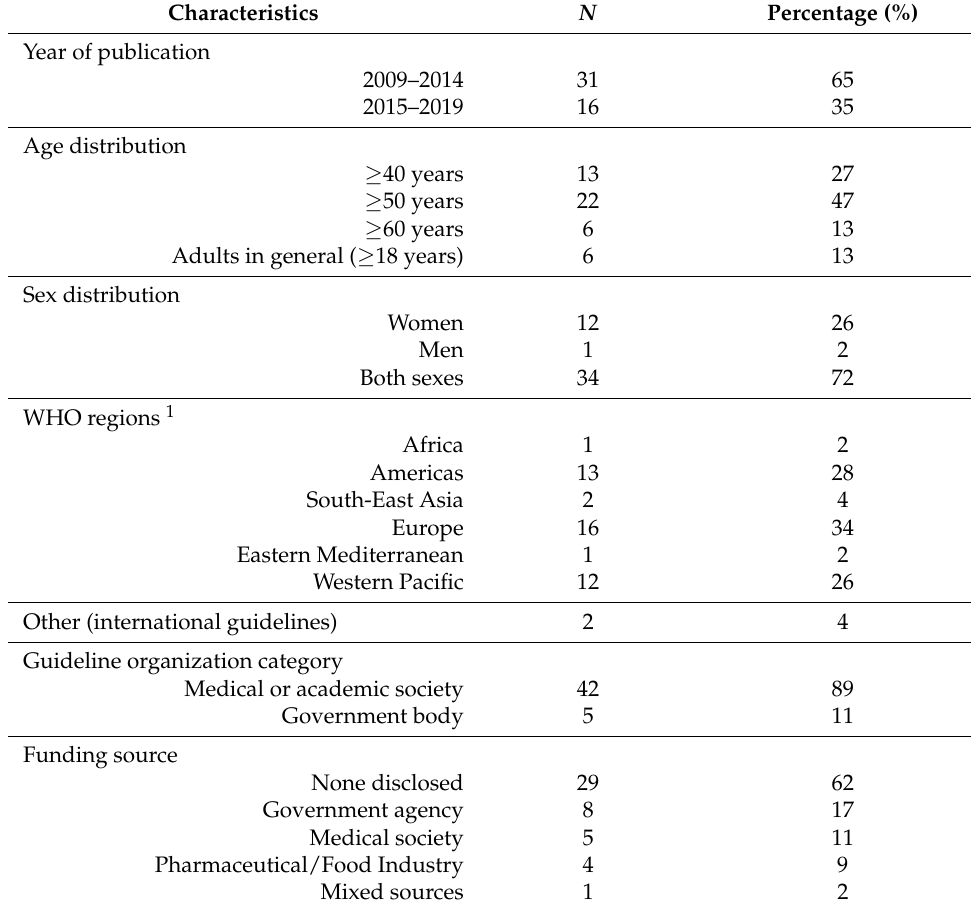
Table 2. Characteristics of included guidelines ( n =